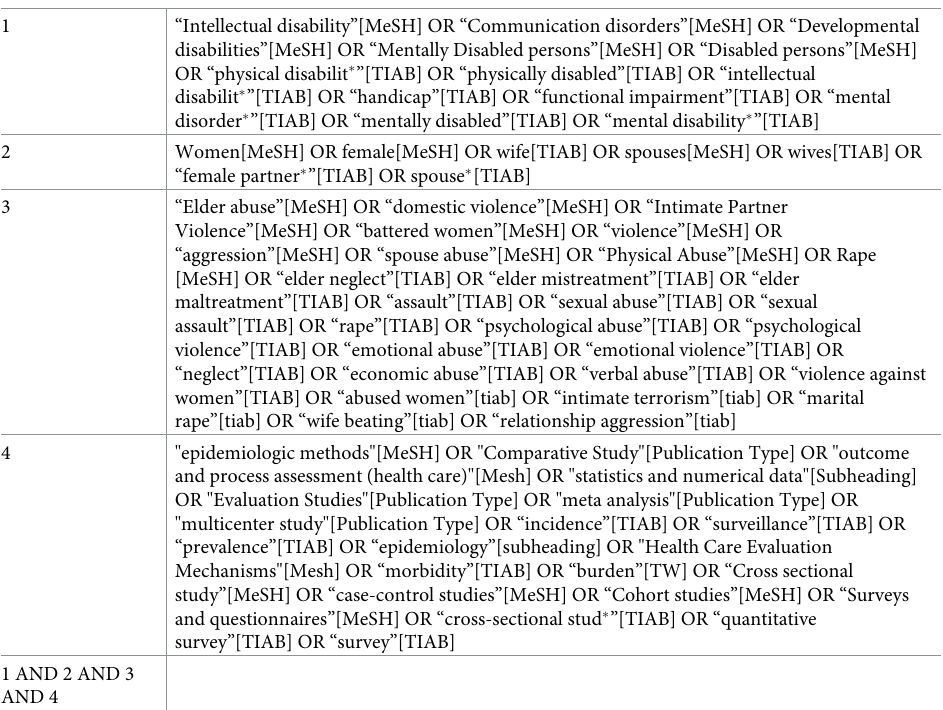
Table 1. PubMed search